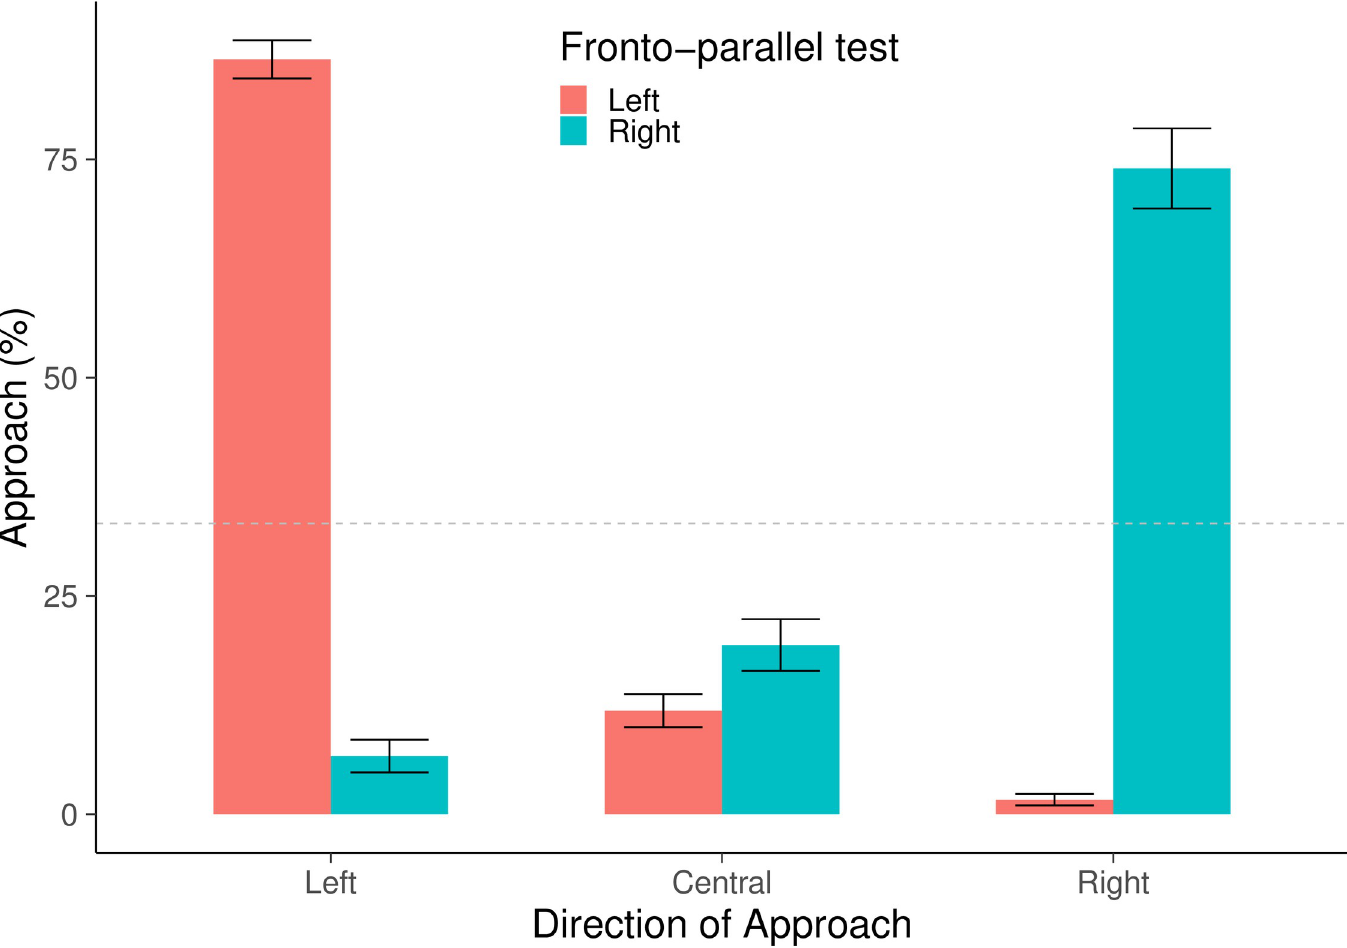
Fig 3. Response times in the monocular fronto-parallel tests. The graphs represent the mean percentage + SE of Response Times for correct and incorrect choices on either side. Results of the left monocular fronto-parallel test, in red; results of the right monocular fronto-parallel test, in blue. differences for correct and incorrect responses on the left as well as on the right (Left Correct: mean = 47.162, ES = 10.233; Left Incorrect: mean = 34.346, ES = 4.881; BF = 0.868; Right Cor- rect: mean = 29.383, ES = 2.882; Right Incorrect: mean = 36.471, ES = 7.351; BF = 0.730). Null evidence was provided also when we compared the response times in relation to the side (left vs. right) first approach to the series (Left: mean = 23.996, ES = 2.192; Right: mean = 24.440, ES = 7.956; BF = 0.482). Since in the first four trials no chicks approached the series from the right, we could not run the analysis on the very first trials (this indicates that also chicks that selected the right elements, did approach the series from the left side). Direction of approach. A Bayesian Repeated Measures ANOVA, with the direction of approach (central, left, right) as a repeated measures factor and the test order as between fac- tor, showed a null evidence for the test order, BF = 0.274 and an extreme evidence for the direction of approach, BF > 100 (Fig 4).